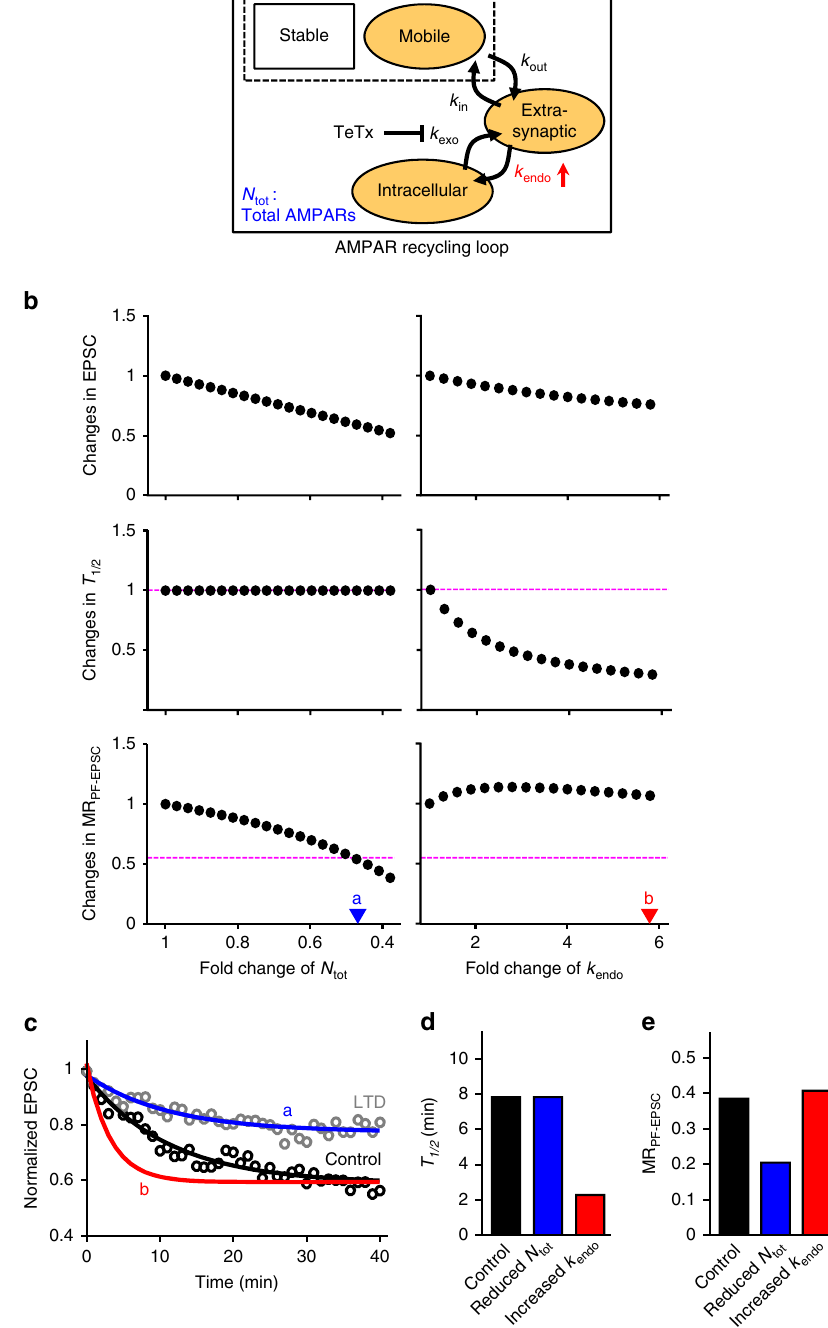
Fig. 2 Model con fi rmation of the reduction in the number of recycling AMPARs. a Diagram of the model. Two possible pathways for implementing LTD maintenance are considered: increase in the traf fi cking speed in k endo (increased k endo ), or reduction in total AMPAR numbers in the recycling loop (reduced N tot ). b Changes in EPSC level ( top ), and changes in T 1/2 ( middle ) or MR PF-EPSC ( bottom ) of k exo inhibition-mediated reduction, when N tot is reduced ( left ) or k endo is increased ( right ) in the model. Values a and b were used for c – e . Magenta dotted lines show values calculated from experimental results shown in Fig. 1c, d. c Time course of changes in EPSC amplitudes, when k exo was inhibited in the model ( solid lines ). The black line was obtained by adjusting parameters (Supplementary Table 1) to reproduce the experimental result at baseline. Speci fi c values of reduced N tot (a shown in b ) and of increased k endo (b shown in b ) were used to obtain blue and red lines , respectively. Circles are the experimental results shown in Fig. 1b. d , e T 1/2 d and MR PF- EPSC e in the k exo inhibition-dependent EPSC reductions obtained from the data shown in c